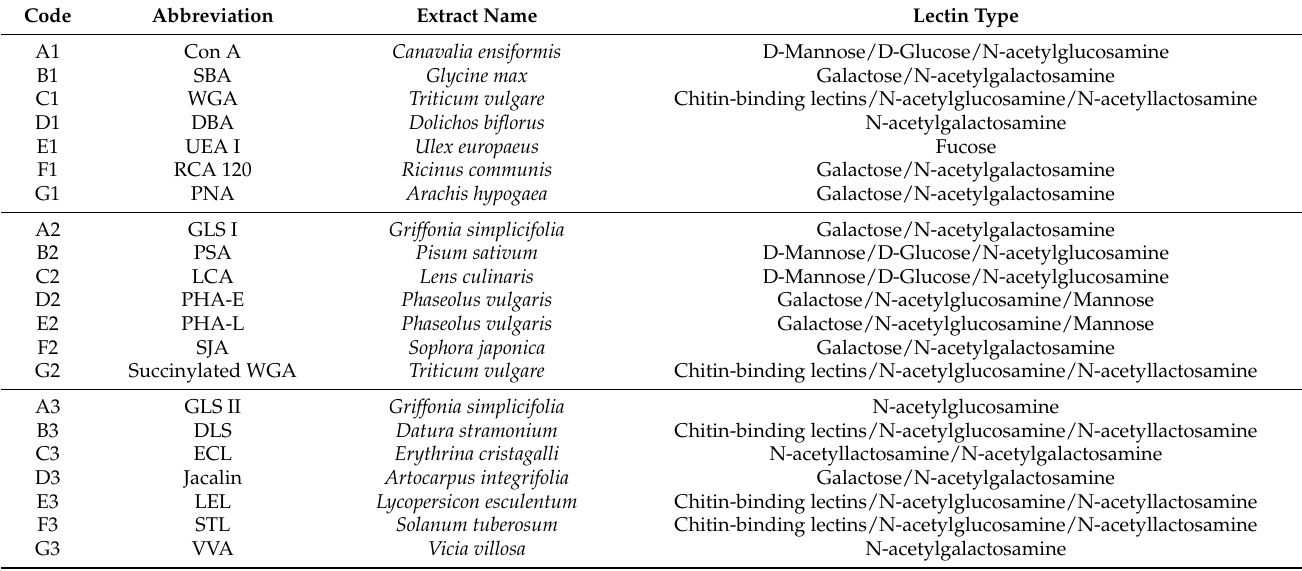
Table 1. Biotinylated Lectins: code (1, 2, 3 series), abbreviation, extract name and type. Binding preference and specificities of each lectin are reported in 65 and